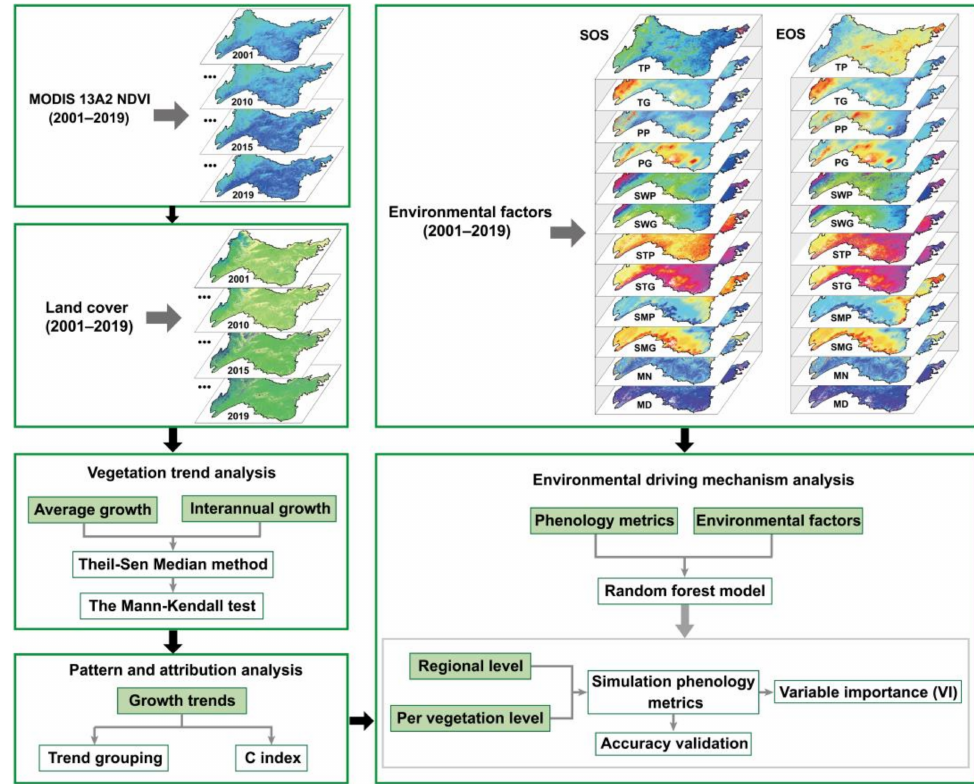
Figure 3. Flowchart of the method used in this study. MODIS 13A2 NDVI (2001–2019), in which the spatiotemporal distributions of NDVI for 2001, 2010, 2015 and 2019 are presented as examples of NDVI time series used as extract phenology metrics. Land cover (2001–2019), in which the spatiotemporal distribution of land cover for 2001, 2010, 2015 and 2019, used as an example of the changes in different vegetation types. Environmental factors, the first column indicates the drivers for SOS and the second column indicates the drivers for EOS, and shows the spatial distribution of each driver separately, which is used to example the predictors used for RF